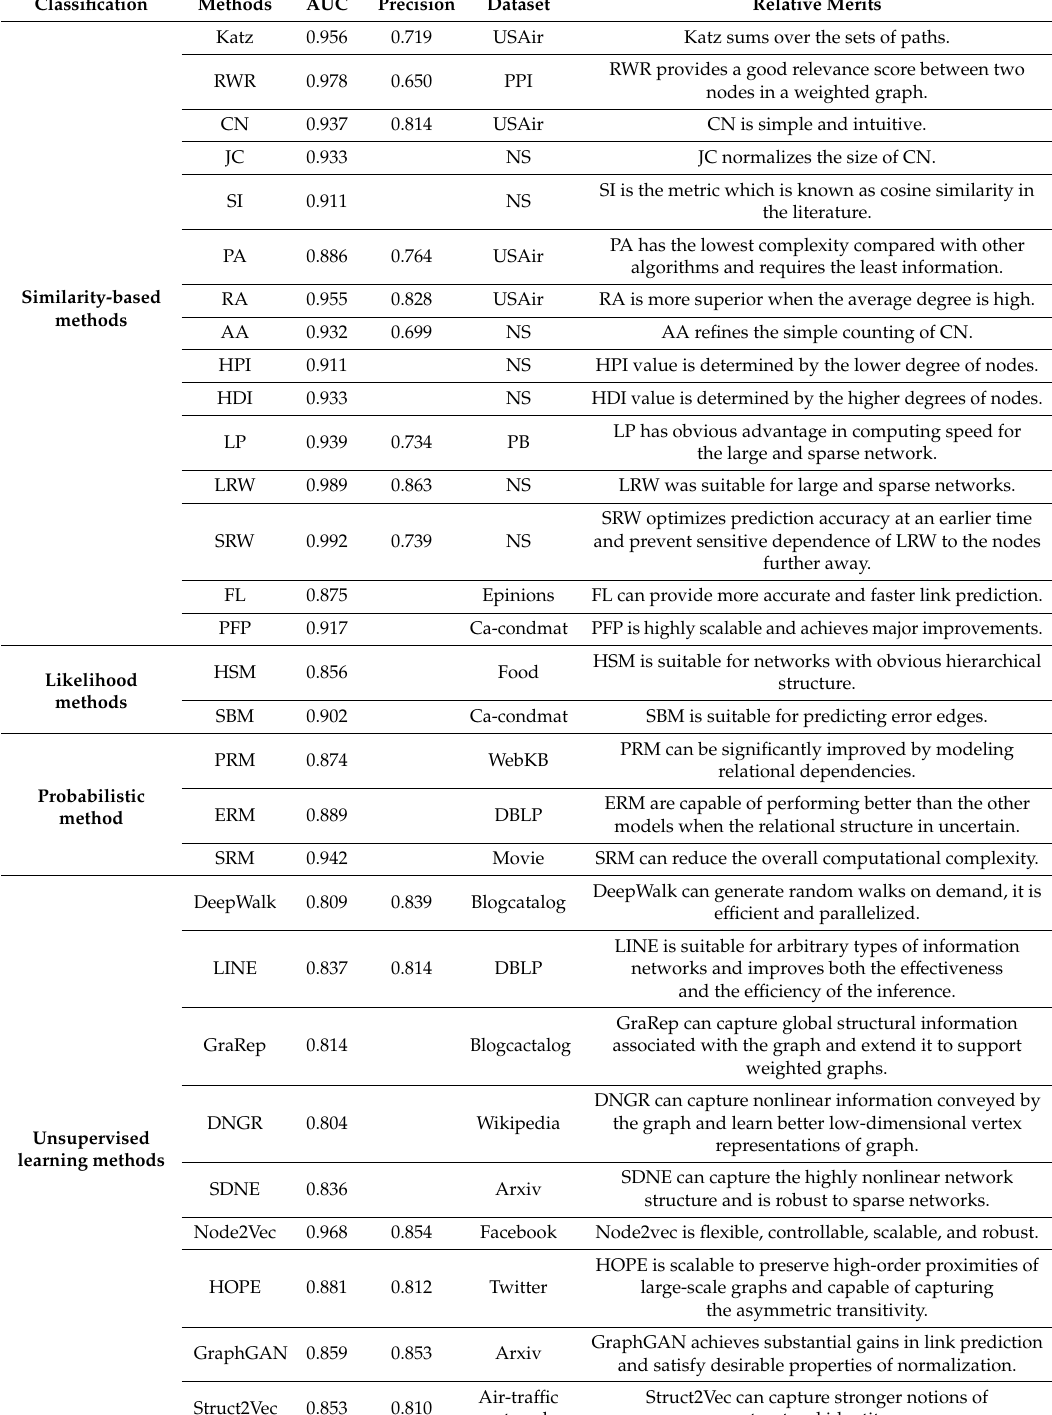
Table 4. Experimental comparison and advantages of link prediction